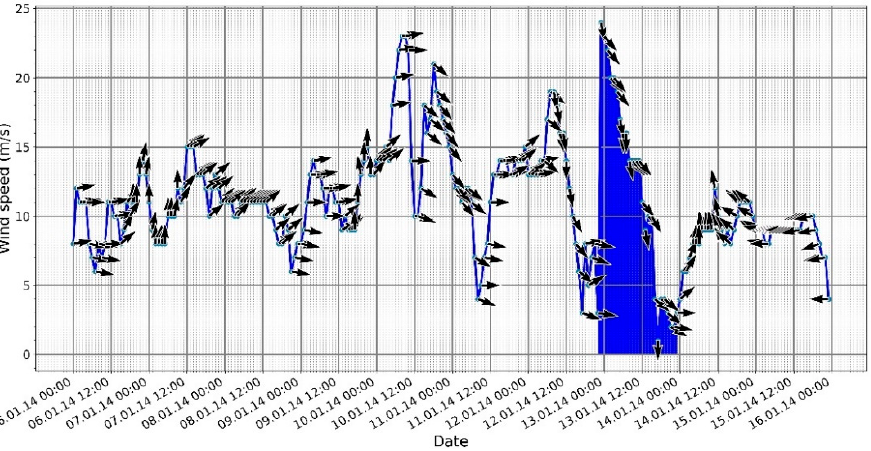
Figure 5. Change in wind speed (graph) and wind direction (arrows) from 6 January 2014 to 16 January 2014.